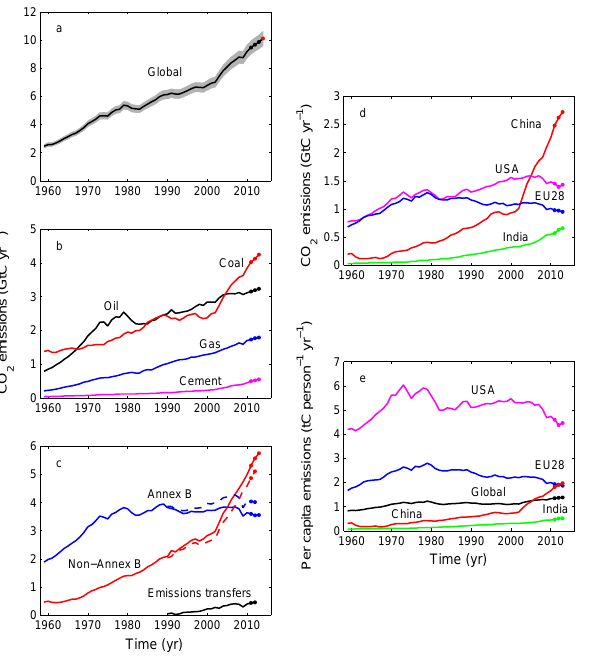
Figure 5. CO 2 emissions from fossil fuel combustion and cement production for (a) the globe, including an uncertainty of ± 5% (grey shading), the emissions extrapolated using BP energy statis- tics (black dots) and the emissions projection for year 2014 based on GDP projection (red dot); (b) global emissions by fuel type, in- cluding coal (red), oil (black), gas (blue), and cement (purple) and excluding gas flaring, which is small (0.6% in 2013); (c) territorial (full line) and consumption (dashed line) emissions for the coun- tries listed in Annex B of the Kyoto Protocol (blue lines; mostly advanced economies with emissions limitations) versus non-Annex B countries (red lines) – also shown are the emission transfers from non-Annex B to Annex B countries (black line); (d) territorial CO 2 emissions for the top three country emitters (USA – purple; China – red; India – green) and for the European Union (EU; blue for the 28 member states of the EU in 2012); and (e) per capita emis- sions for the top three country emitters and the EU (all colours as in panel d ) and the world (black). In (b) to (e) , the dots show the data that were extrapolated from BP energy statistics for 2011, 2012, and 2013. All time series are in GtC yr − 1 except the per capita emis- sions (panel e ), which are in tonnes of carbon per person per year (tCperson − 1 yr − 1 ). All territorial emissions are primarily from Bo- den et al. (2013) as detailed in the text; consumption-based emis- sions are updated from Peters et al. (2011a).